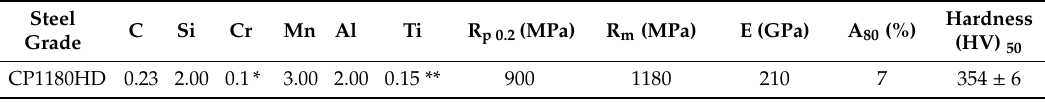
Table 3. Nominal chemical composition, wt %, and mechanical properties of the sheet